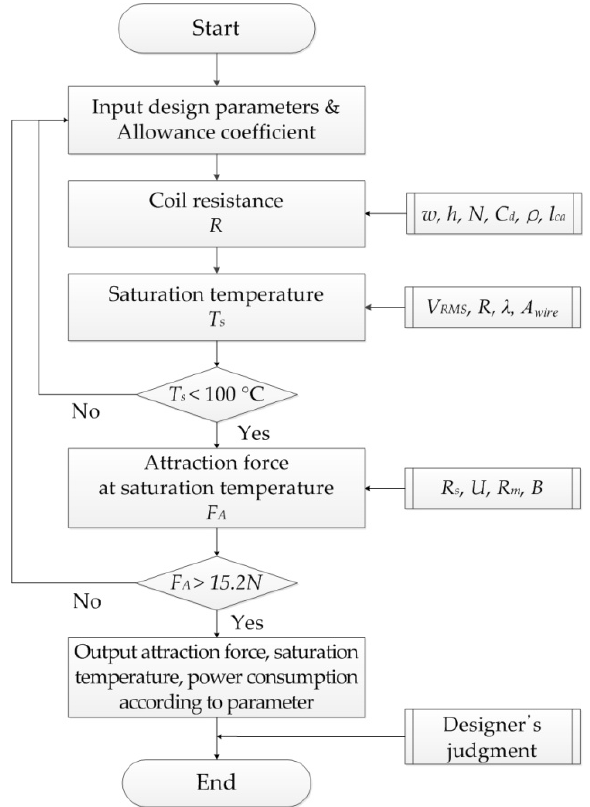
Figure 7. Procedure of optimal design. Table 2. Optimization results.